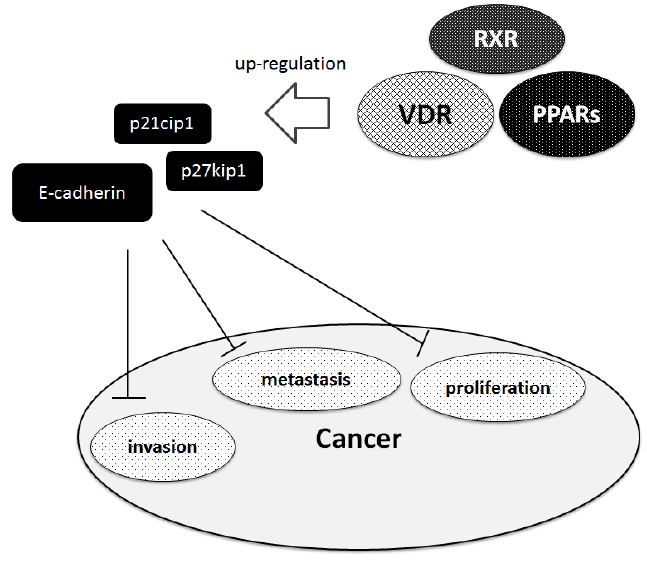
Figure 3. Implication of VDR, PPARs, and RXR in inhibition of cancer. VDR, PPARs, and RXR may be involved in inhibition of several aspect including proliferation, metastasis and invasion in cancer. Hammerheads mean inhibition. Note that some critical pathways have been omitted for